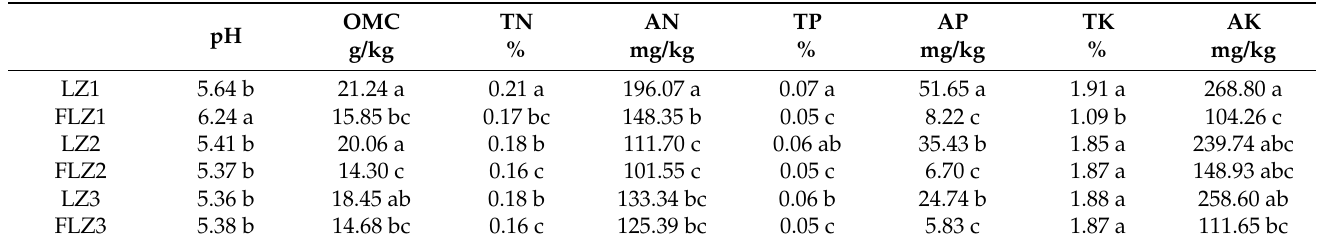
Table 2. Chemical properties of soils from different treatment plots.